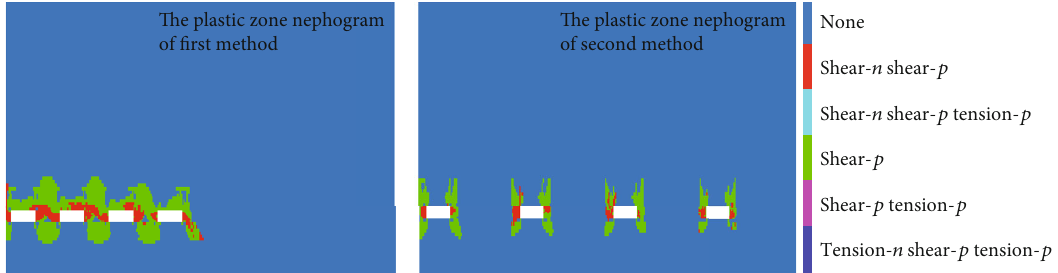
Figure 9: The plastic zone nephogram of the coal pillar of the fourth borehole.